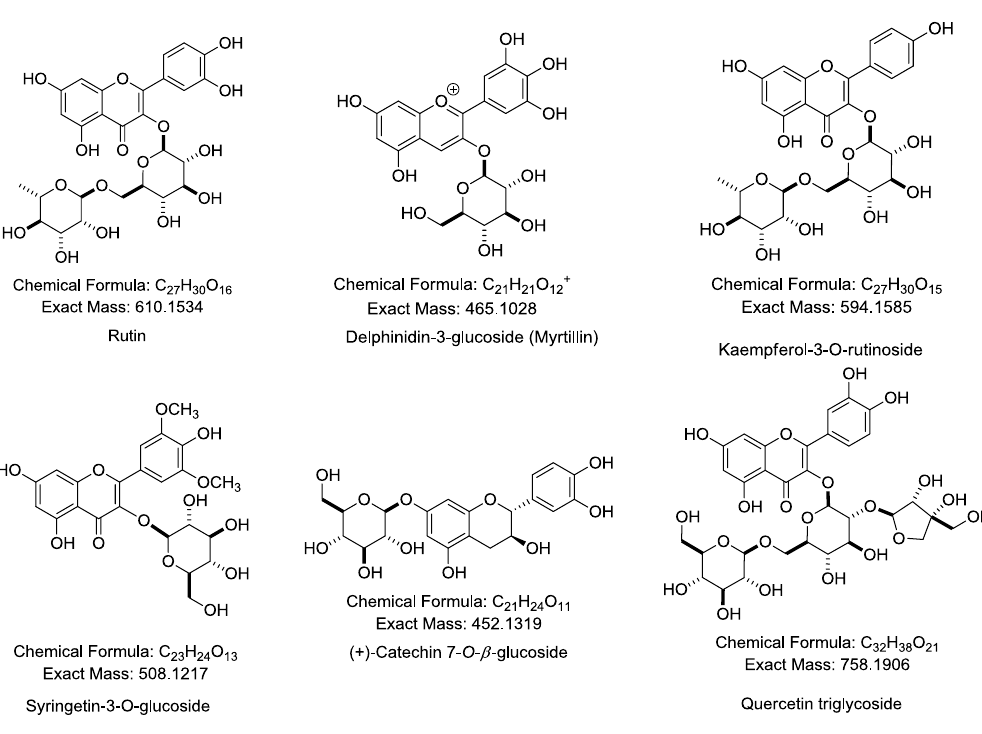
Figure 2. Structures of identified compounds listed in Table 1.